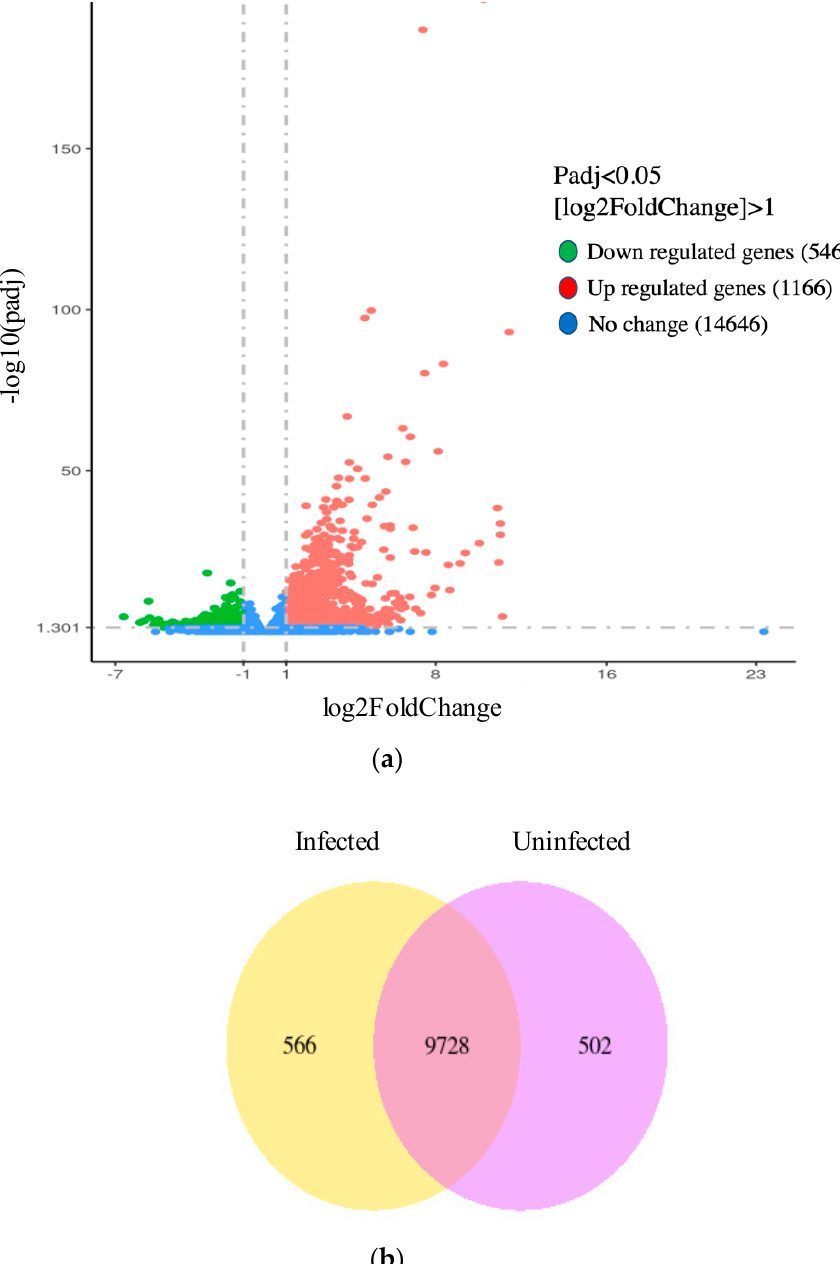
Figure 2. ( a ) Volcano plot showing differential expression (X-axis) across treatment and expression levels within groups (Y-axis), where (padj) is the adjusted p -value. ( b ) A total of 566 genes were uniquely expressed in infected colonies (yellow), 9728 were expressed in both infected and uninfected colonies (overlap), and 502 genes were uniquely detected in uninfected colonies.